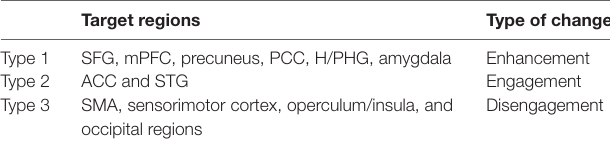
TABLE 1 | Three types of change in the functional connectivity of the angular gyrus during imagined music performance compared with resting